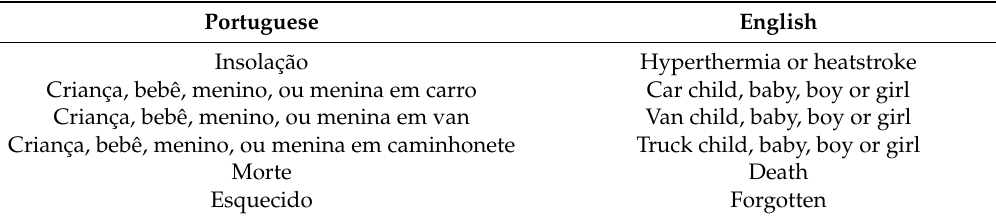
Table 1. Key word search in Portuguese and English for children left unattended in motor